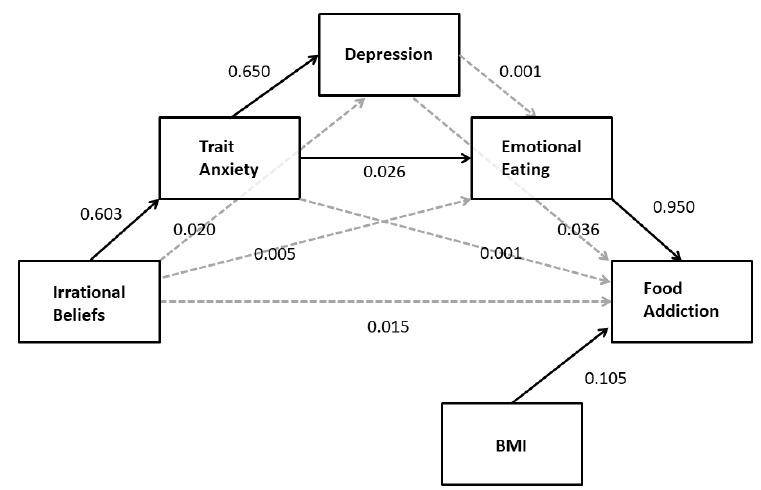
Figure 4. The relationship between irrational beliefs and FA is mediated by the serial pathway through trait anxiety and emotional eating. Solid arrows indicate statistically significant regression coefficients. Nonsignificant BMI effects on mediators are not included for simplicity.